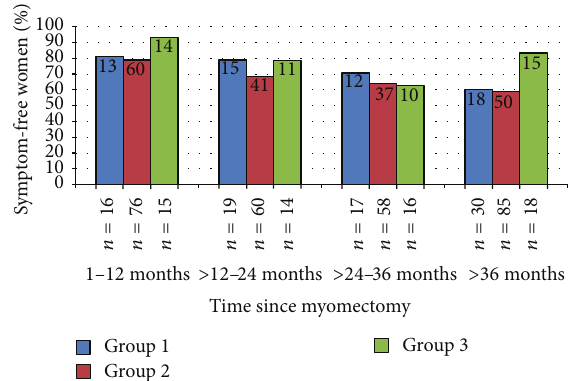
Figure 1: Women who were symptom- and condition-free since myomectomy, by group and time since myomectomy. Group 1 (blue bars) desired to treat symptoms with no intention of becoming pregnant; group 2 (red bars) desired to treat symptoms and preserve ability to get pregnant in the future; group 3 (green bars) desired to improve current chance of pregnancy after myomectomy. 𝑁 in bars is the number of symptom-free women; 𝑁 below the bars is the total number of women in that group and time